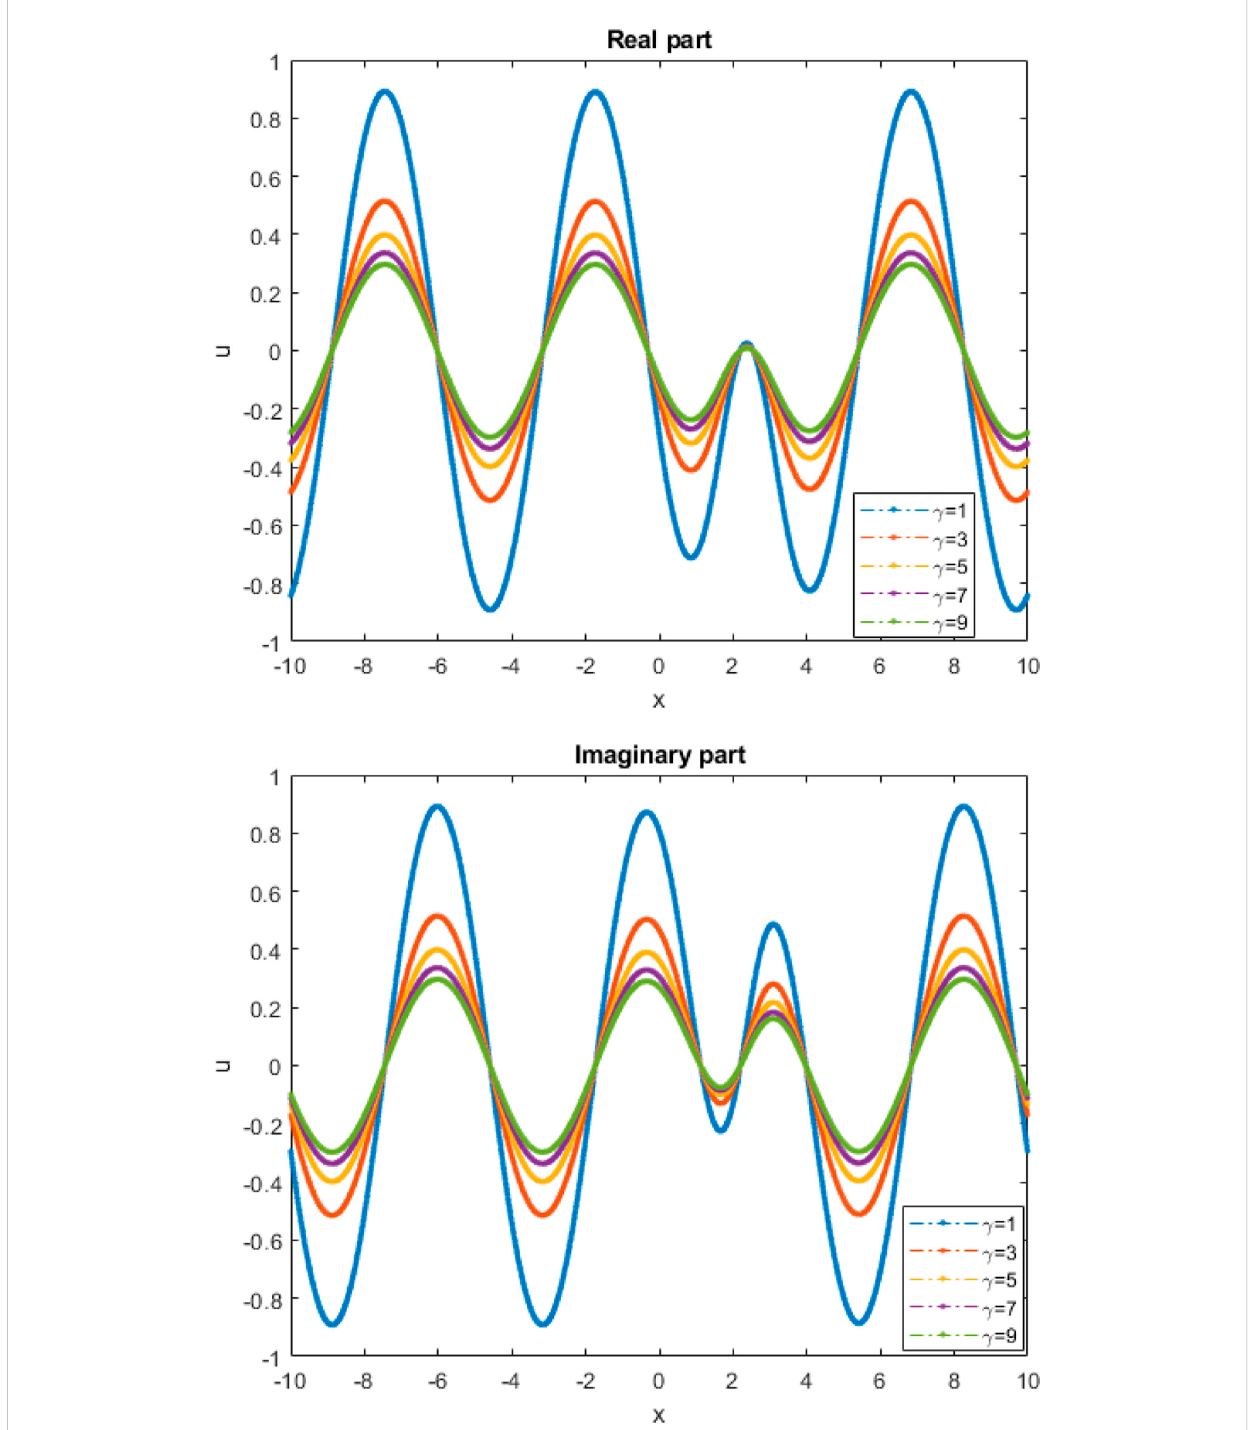
FIGURE 11 Variations of solution (3.16) with k = 1.1, c = − 2.8 and γ = 1, 3, 5, 7, and